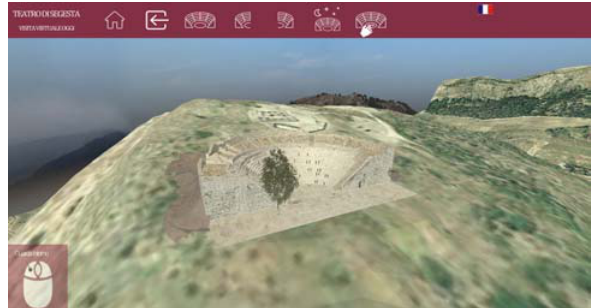
Figure 9. The Theatre of Segesta located on the top of Barbaro